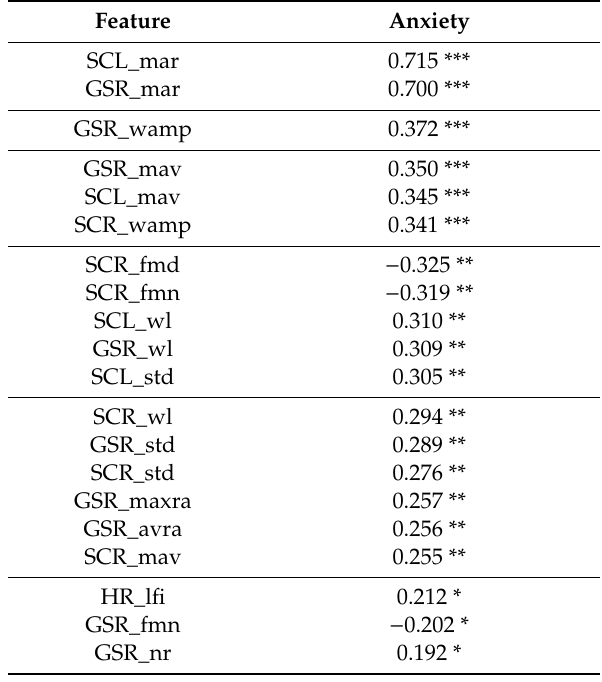
Table 3. Ranking of features that showed the highest degree of correlation with